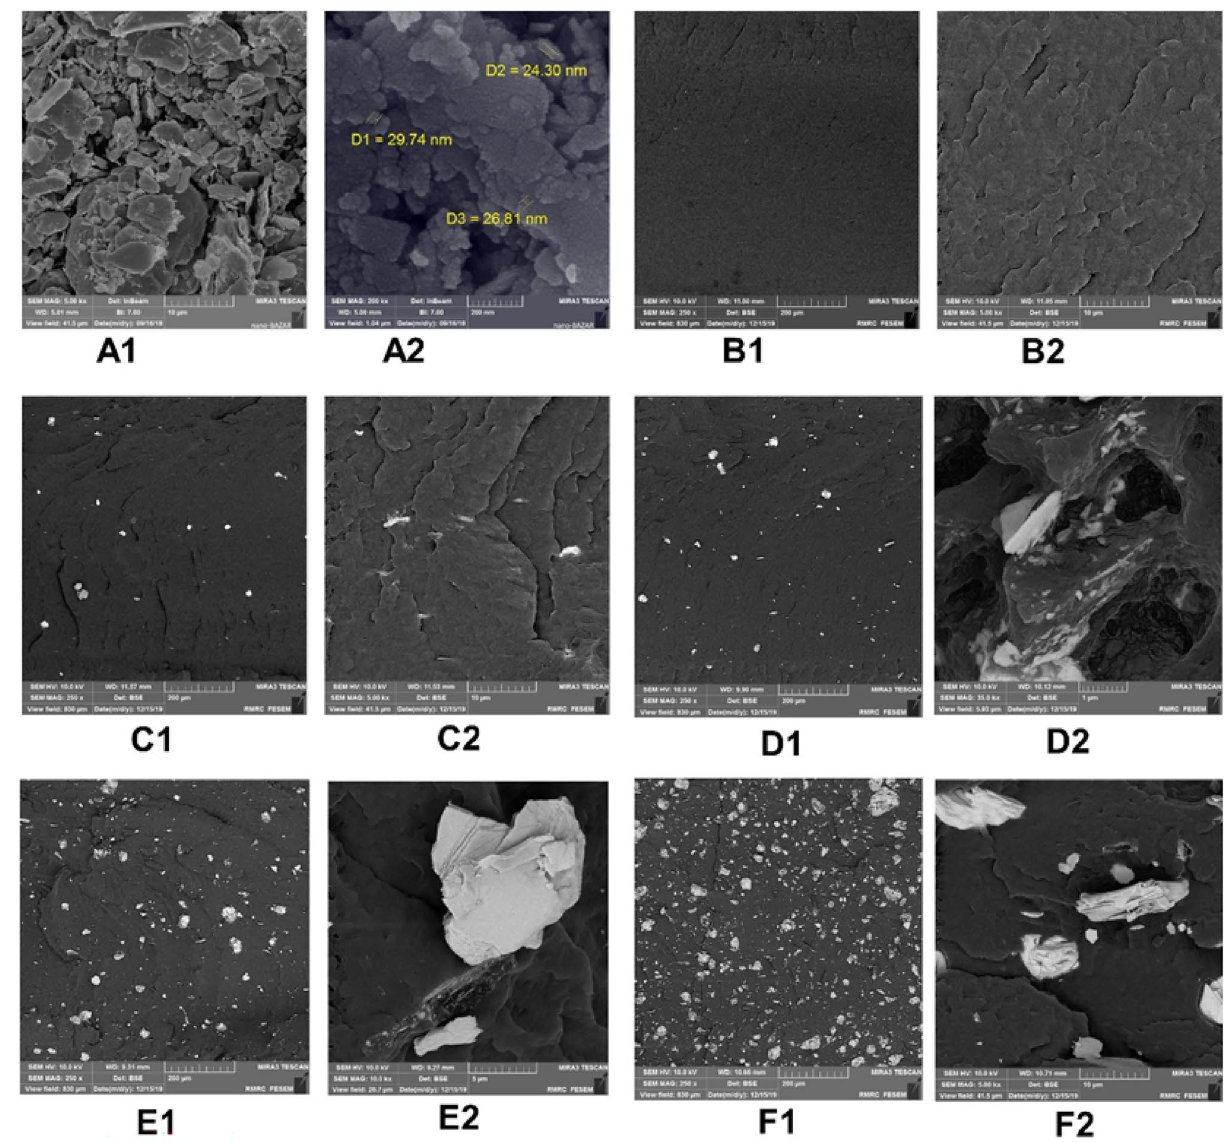
Figure 3. The SEM images of the samples at different magnifications: ( A1,A2 ) PbO, ( B1,B2 ) PA6, ( C1,C2 ) PA6/PbO-5%, (D1,D2 ) PA6/PbO-10%, ( E1,E2 ) PA6/PbO-20%, and ( F1,F2 )